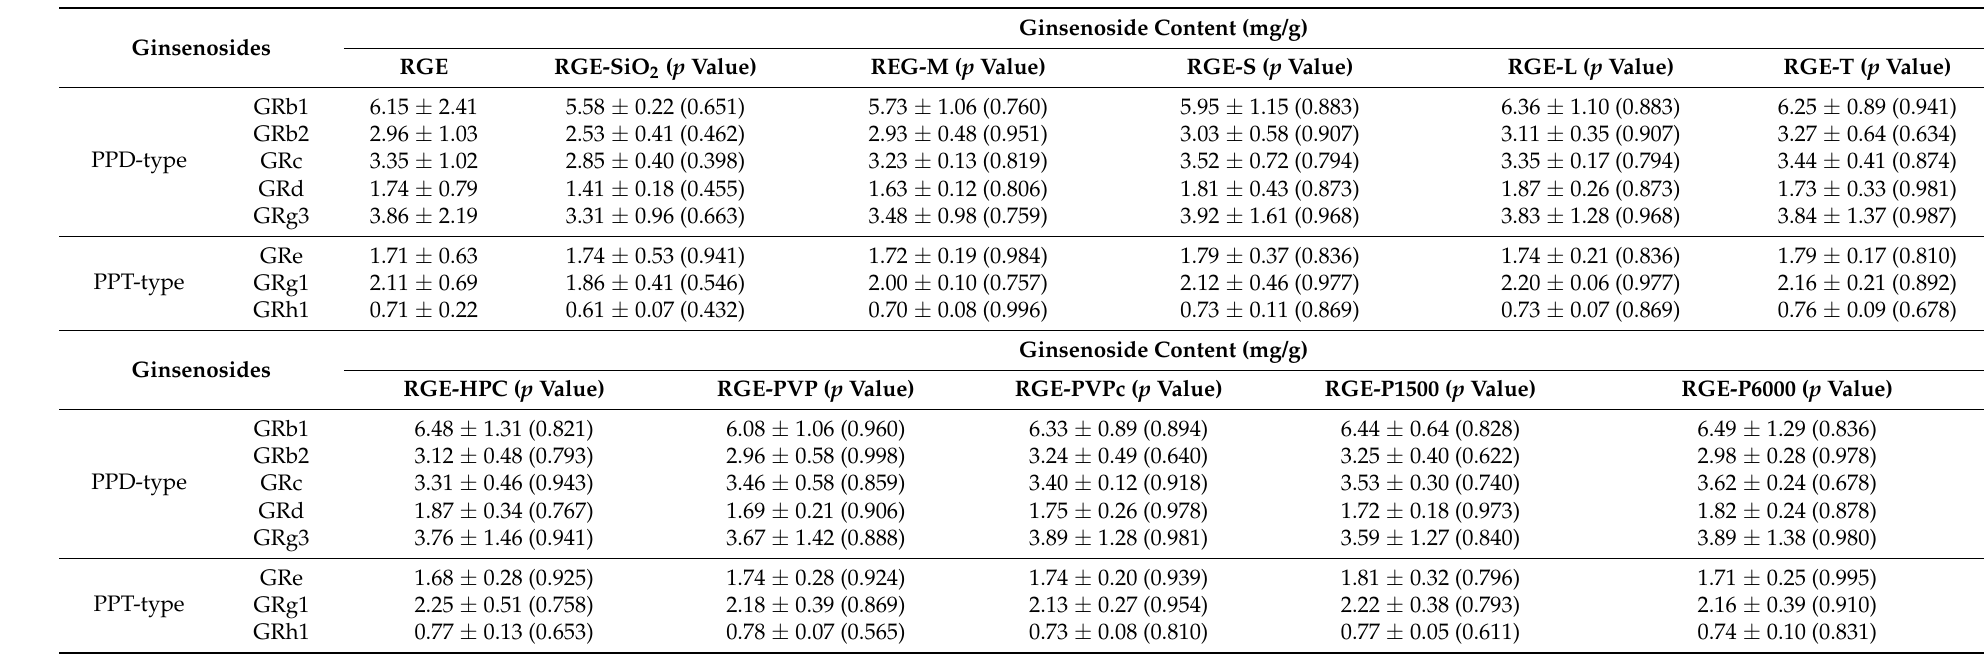
Table 2. Ginsenoside content determined in the solid dispersion of red ginseng